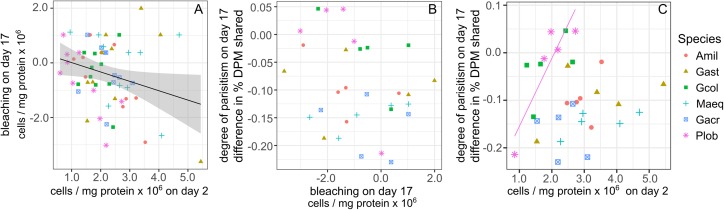
Relationships between changes in symbiont cell density and the proportion of photosynthetically fixed carbon translocated to hosts.(A) Bleaching intensity, calculated as the change in symbiont cell density between control (27 °C) and heat-treated (31 °C) samples on day 17 as a function of symbiont cell density in heat treated corals on day 2. (B) The degree of symbiont parasitism, calculated as the difference in the proportion of photosynthetically fixed carbon translocated to hosts between control and heat-treated samples on day 17. (C) The degree of symbiont parasitism as a function of symbiont cell density in heat treated corals on day 2. Regression line shown for Plob only. Amil: Acropora millepora, Maeq: Montipora aequituberculata, Gcol: Goniopora columna, Plob: Porites lobata, Gast: Galaxea astreata, Gacr: Galaxea acrhelia.